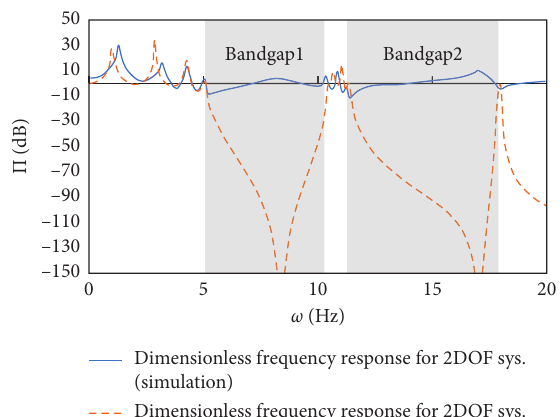
Figure 12: FRA for 2DOF model, comparison of numerical solution (MATLAB/Simulink) with simulation